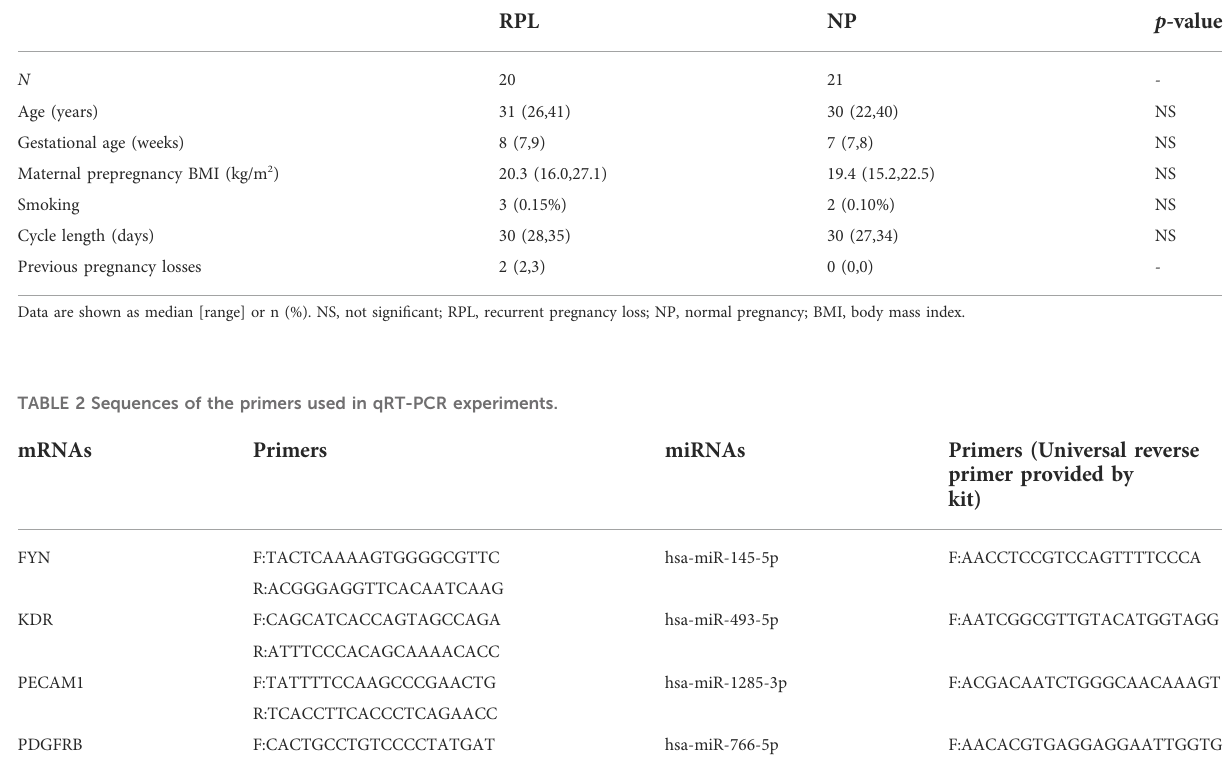
TABLE 1 Clinical characteristics of patients recruited.